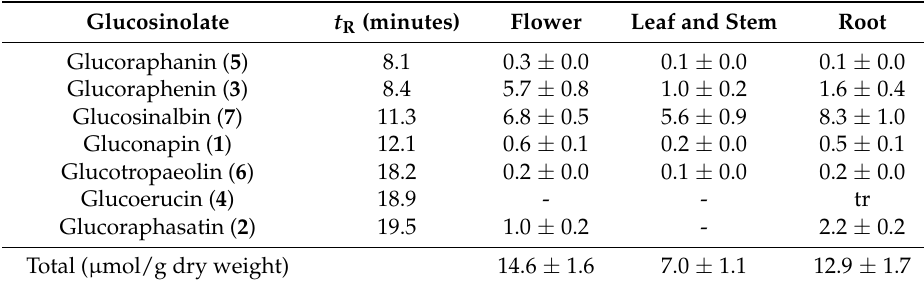
Table 1. Individual concentrations of glucosinolates ( µ mol/g dw) in B. erucago tissues.